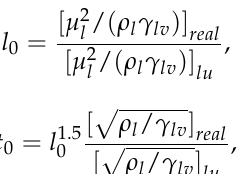
where the subscript ‘real’ represents the physical units, ‘lu’ represents the lattice units, ( µ l ) lu = 0.0177 is the dynamic viscosity, ( ρ l ) lu = 6.62 is the density of droplet and ( γ lv ) lu = 0.159 is the surface tension. Then the velocity scale is determined as v 0 = l 0 / t 0